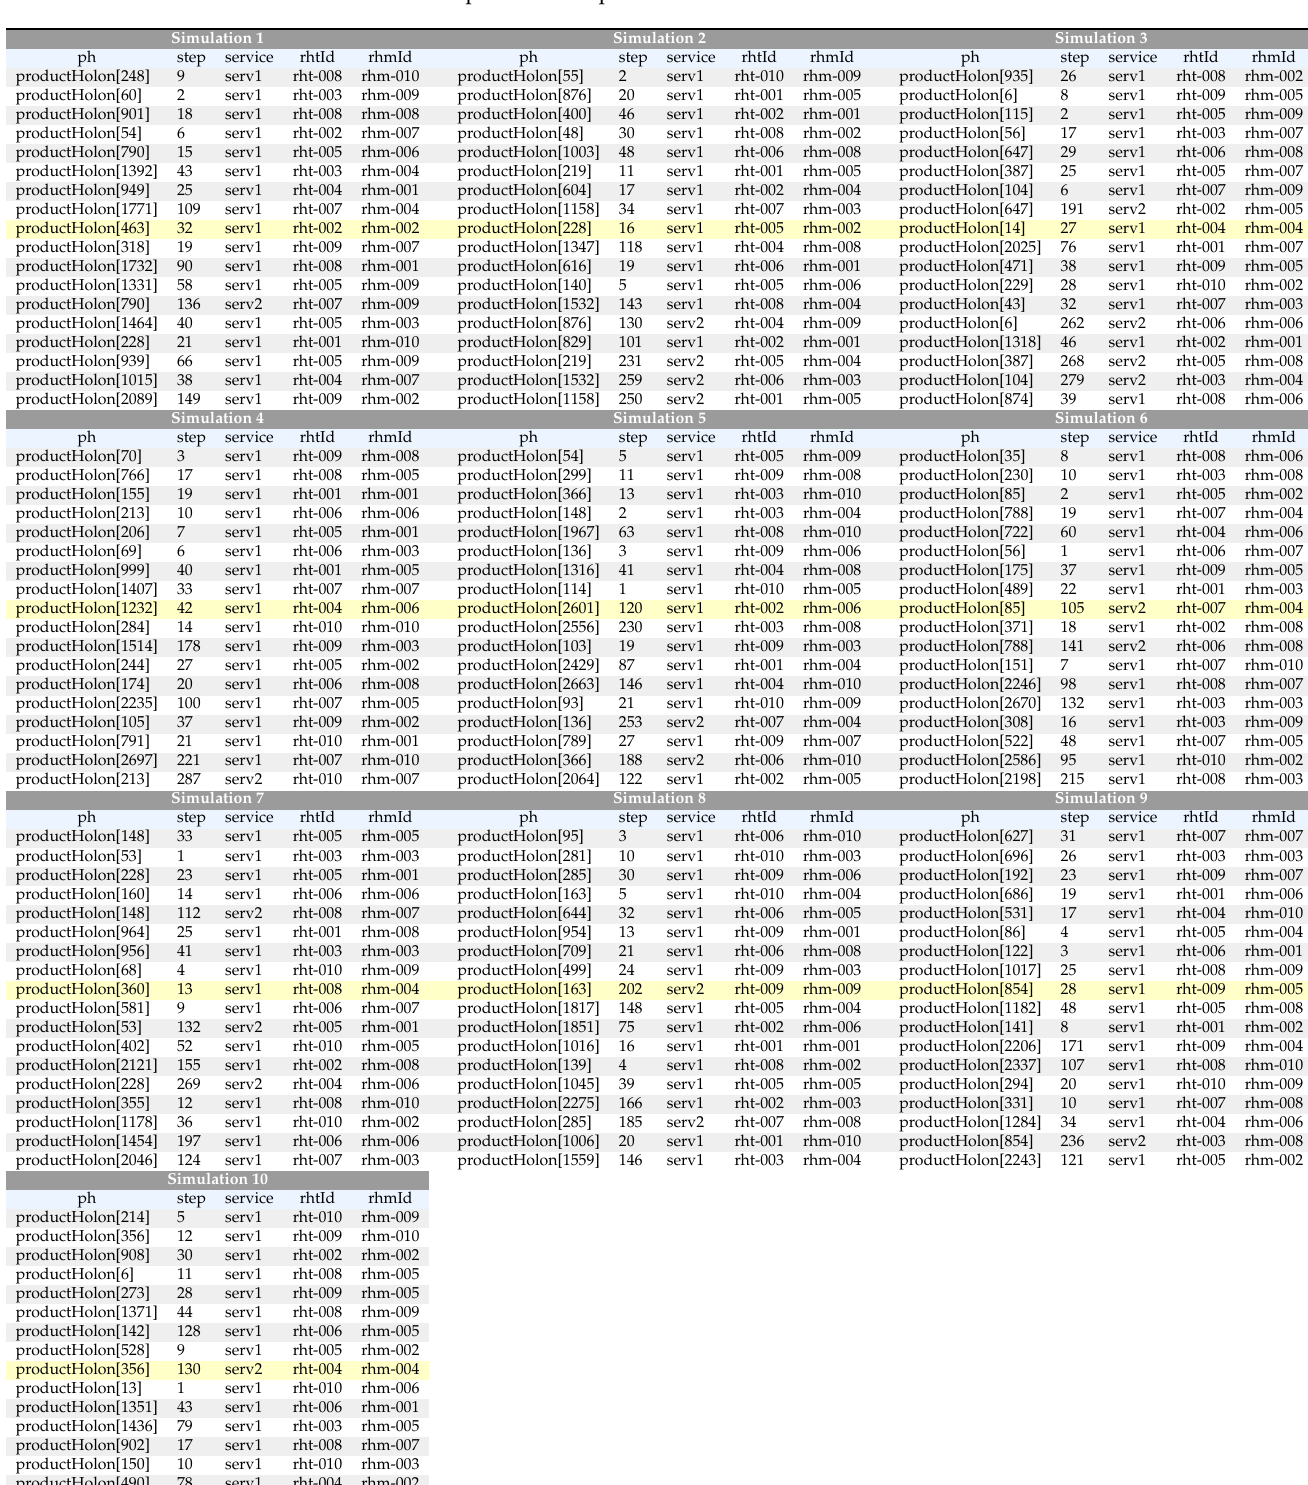
Table 5. Comparison of steps between